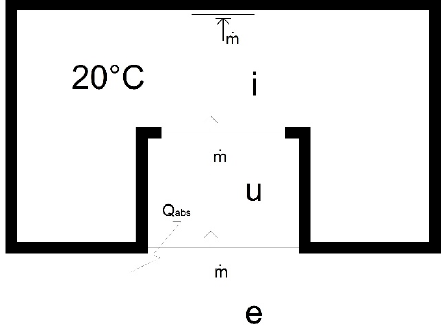
Figure 1. Scheme of operation of the veranda with mechanical air extraction equipment.